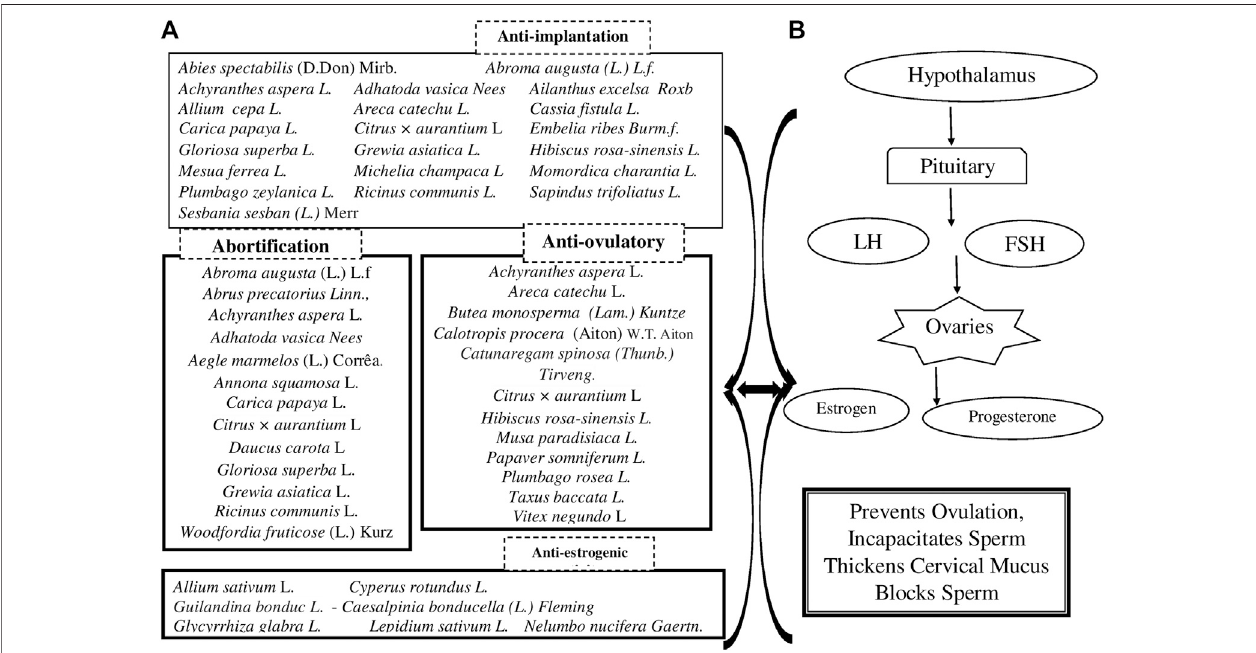
FIGURE 4 | Female contraceptive plants and possible